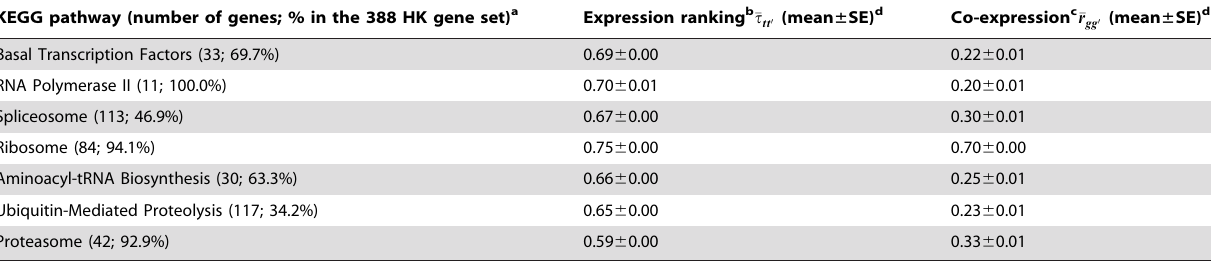
KEGG pathway (number of genes; % in the 388 HK gene set) a